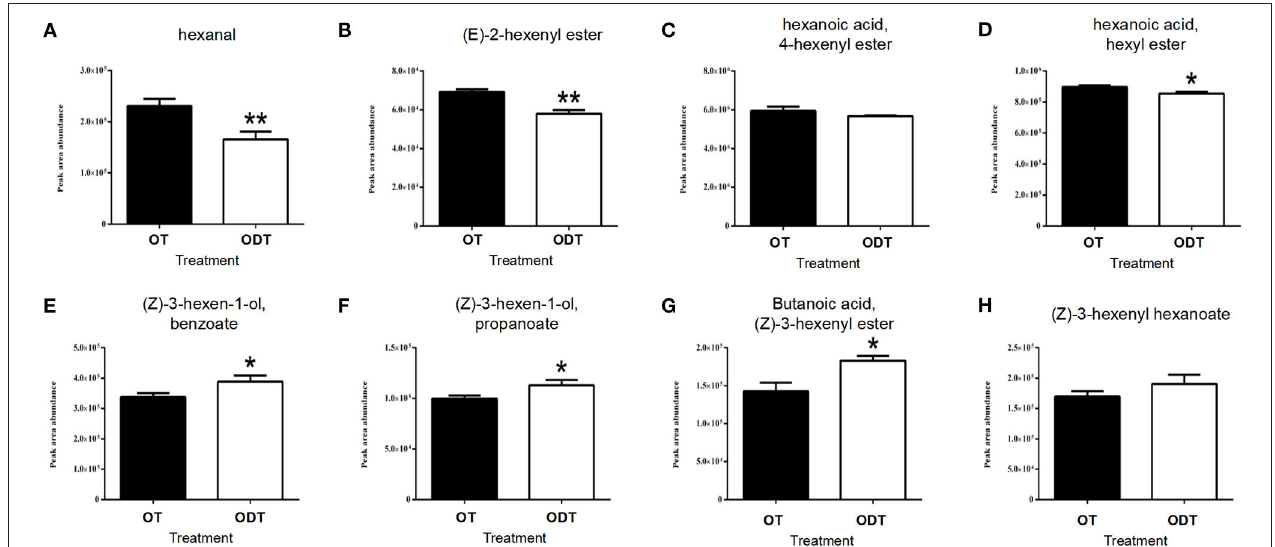
FIGURE 6 | Contents of volatile fatty acid derivatives in raw tea under normoxic and hypoxic conditions during the turnover process of oolong tea. (A) Hexanal, (B) ( E )-2-hexenyl ester, (C) 4-hexenyl hexanoate, (D) hexyl hexanoate, (E) ( Z )-3-hexen-1-yl benzoate, (F) ( Z )-3-hexen-1-yl propanoate, (G) ( Z )-3-hexenyl butanoate, and (H) ( Z )-3-hexenyl hexanoate. Asterisks denote statistically significant differences (* p < 0.05; ** p < 0.01) between relative amounts of OT and ODT. Error bars indicate the standard error (SE) of the